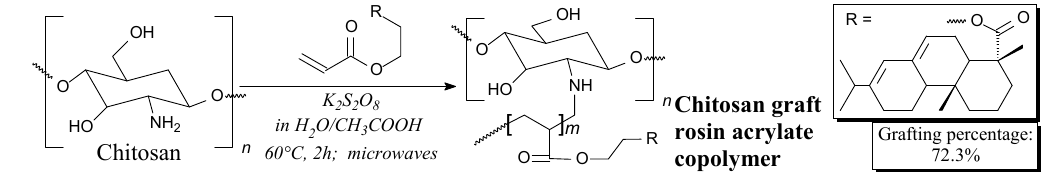
Scheme 77. Preparation of chitosan graft rosin acrylate copolymer.